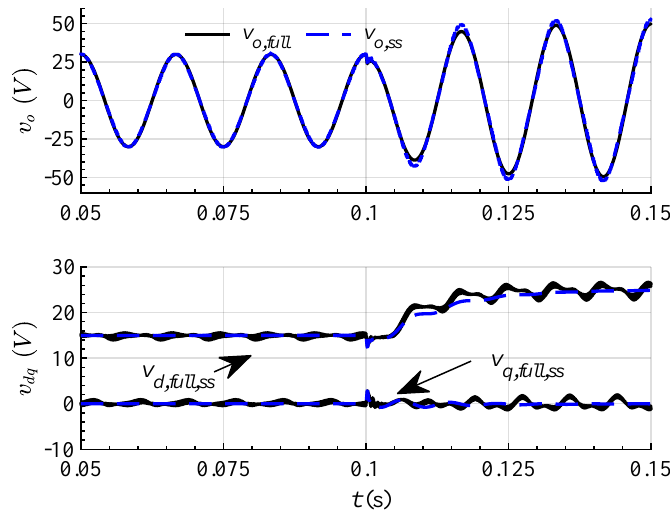
Figure 18. Comparison of the output voltages and the dq axis voltages from both the full order model and the small-signal model of the boost inverter. The d axis reference jumps from 15V to 25V and the q axis reference remains fixed at 0V.